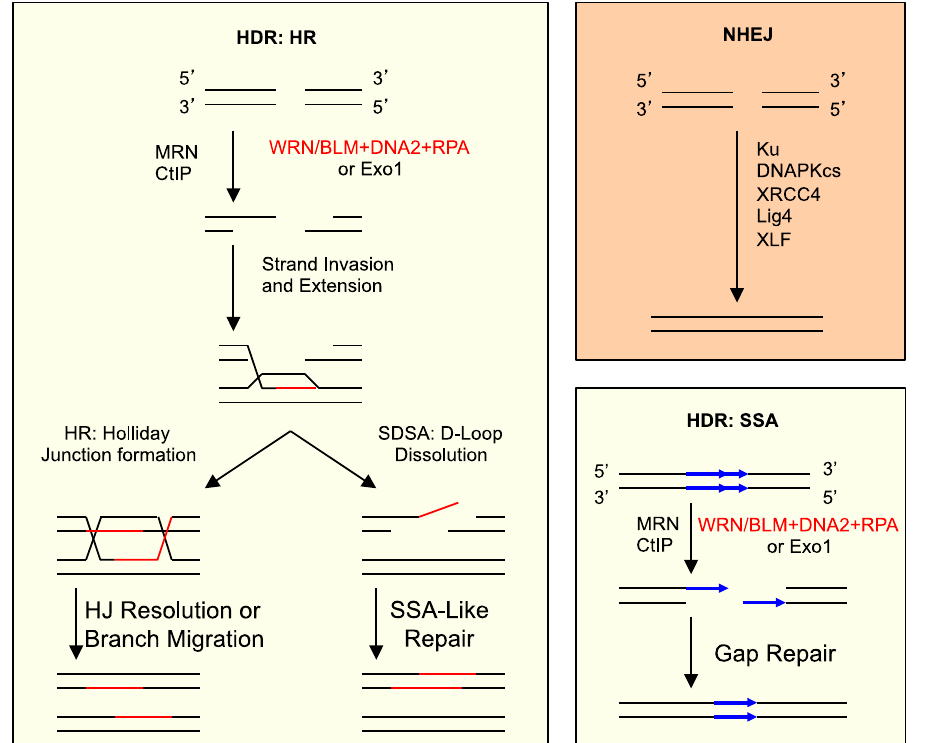
Figure 4. Major DSB repair pathways and 5 1 strand resection in eukaryotes. Non-homologous end joining (NHEJ) involves limited or no processing of ends. Homology-dependent repair (HDR) consists of homologous recombination (HR) and single-strand annealing (SSA), both of which depend on 5 1 strand resection and sequence homology for repair. Resection is carried out by either the 5 1 - > 3